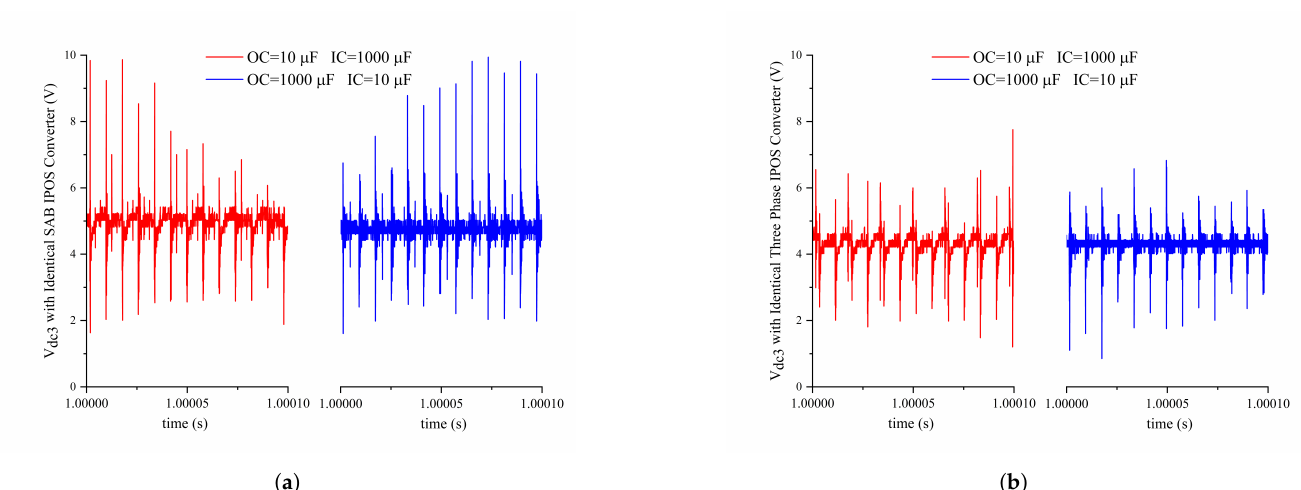
Figure 13. Comparison of the waveform of V dc3 under different situations. ( a ) V dc3 with Identical SAB IPOS Converter; and ( b ) V dc3 with Identical Three Phase IPOS Converter.